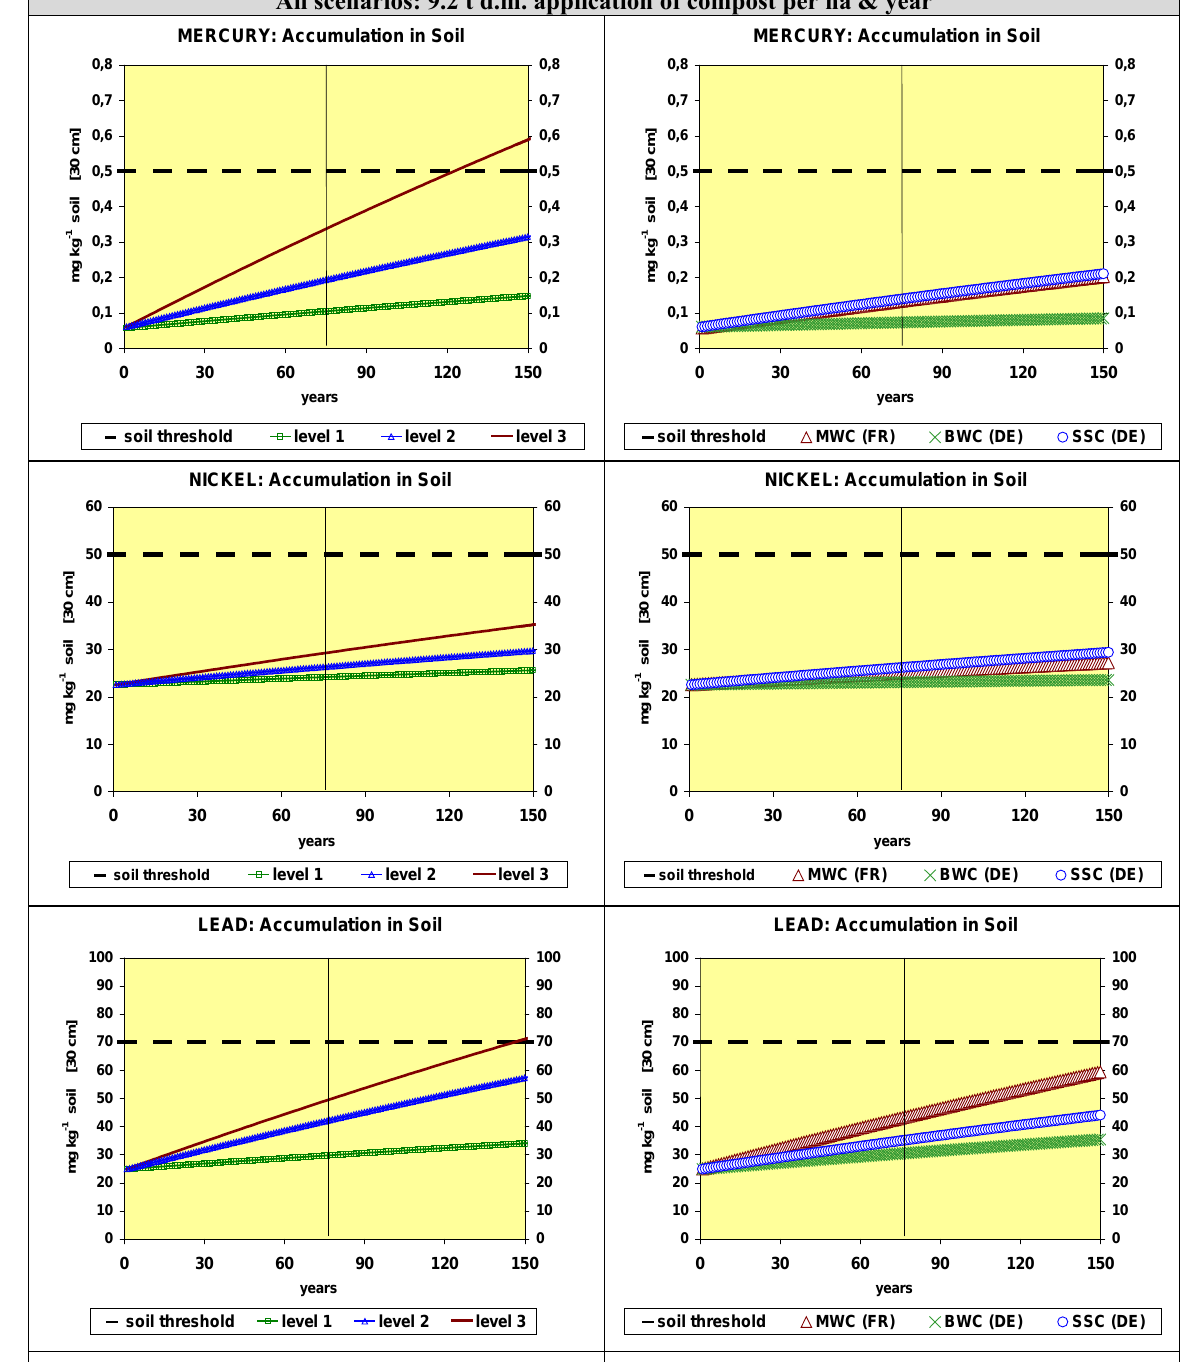
Figure 9 (cont.): Accumulation of heavy metals in soil assuming the continuous application of composts with metal concentrations at 3 limit scenarios